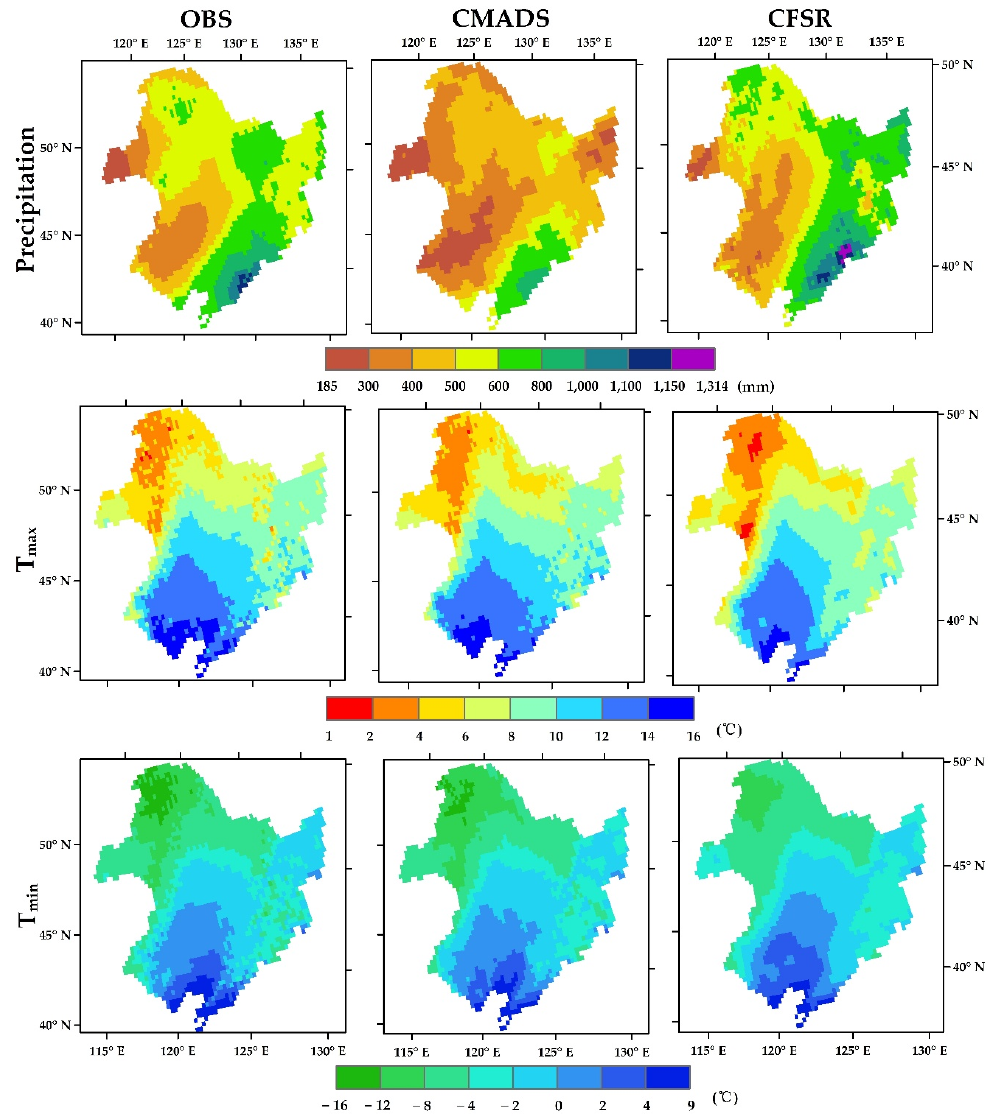
Figure 3. Spatial distribution of CMADS, CFSR, and observed data. Marks: The figures in the first, second, and third lines show the spatial distributions from annual average precipitation, maximum temperature, and minimum temperature, respectively.